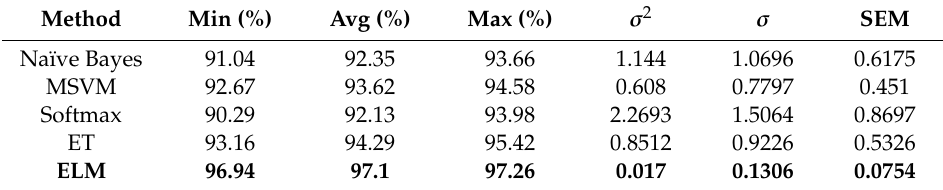
Table 11. Detailed statistical analysis of the proposed method using the BraTS 2017 dataset.